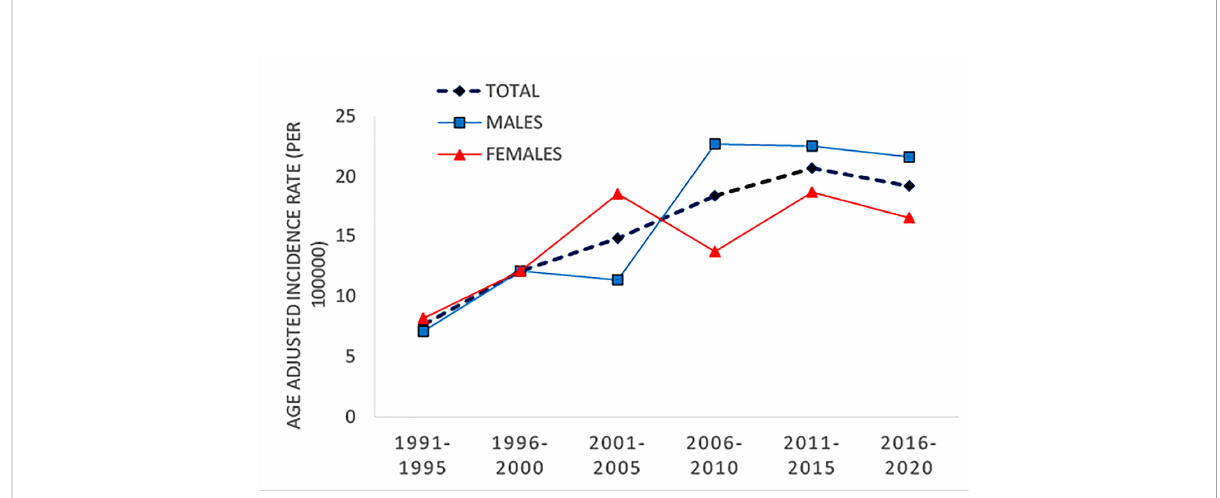
FIGURE 1 Trend of age-adjusted incidence rate (per 100,000), Montenegro, 1991 –